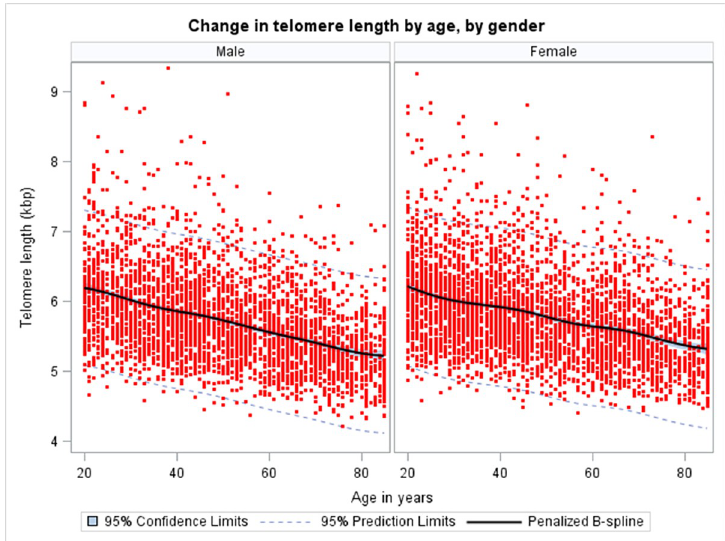
Fig 1. Telomere Length by Age and Gender in NHANES 1999–2002. (a) Male ( β = -0.0153; p-value < 0.001), (b) Female ( β = -0.0129; p-value < 0.001). Estimates, obtained from linear regression with telomere length (kbps) as outcome and age (years) as predictor, are adjusted for ethnicity, physical activity, allostatic load and comorbidity index.